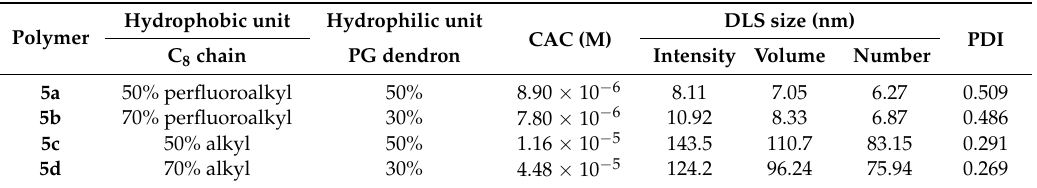
Table 1. Critical aggregation concentration (CAC) and particle size distribution profile of the nanostructures in aqueous solution.